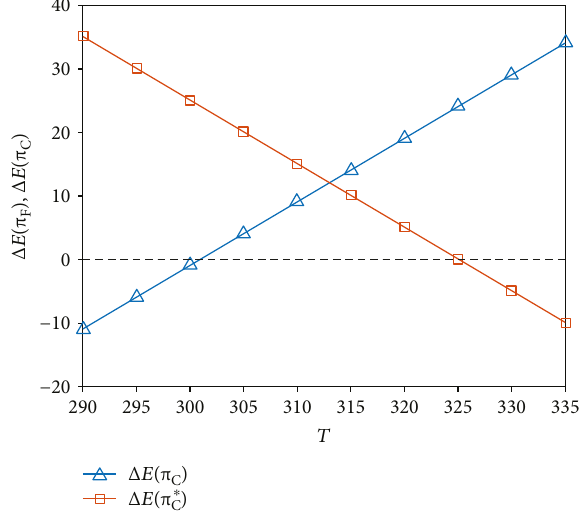
Figure 10: E ff ect of risk transfer fees T on supply chain